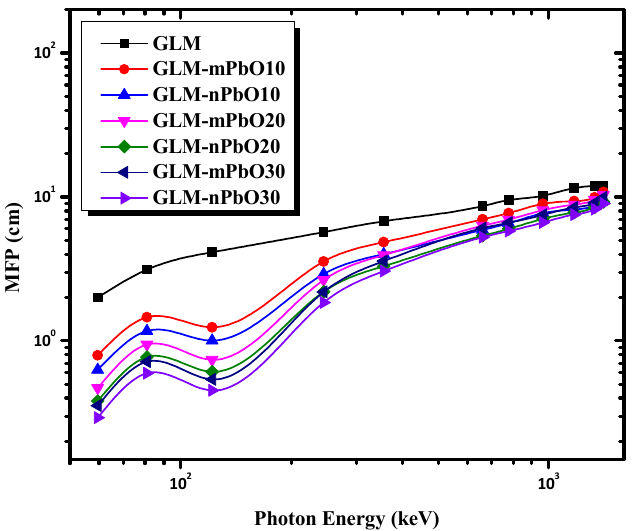
Figure 6. The variation of TVL as a function of photon energy for micro- and nano-PbO mortars.